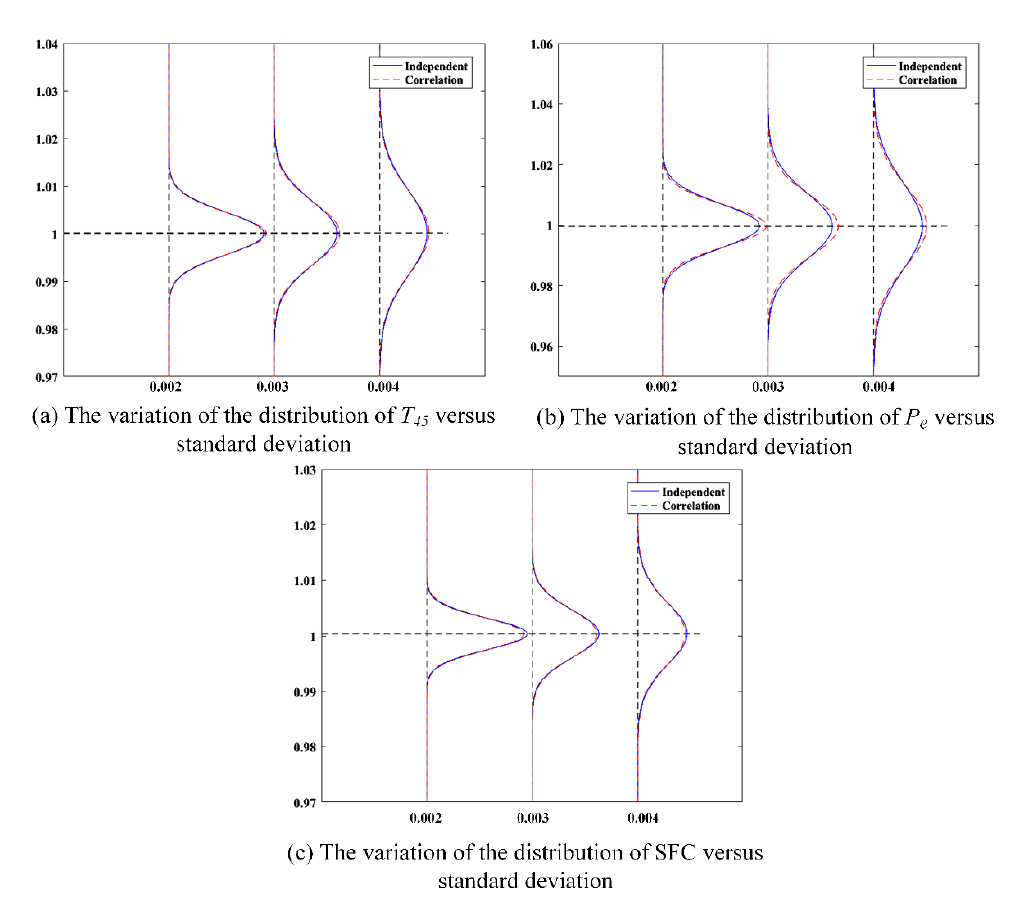
Figure 5. ( a ) The variation of the distribution of T 45 versus standard deviations of the six uncertain parameters; ( b ) the variation of the distribution of P e versus standard deviations of the six uncertain parameters; ( c ) the variation of the distribution of SFC versus standard deviations of the six uncertain parameters.